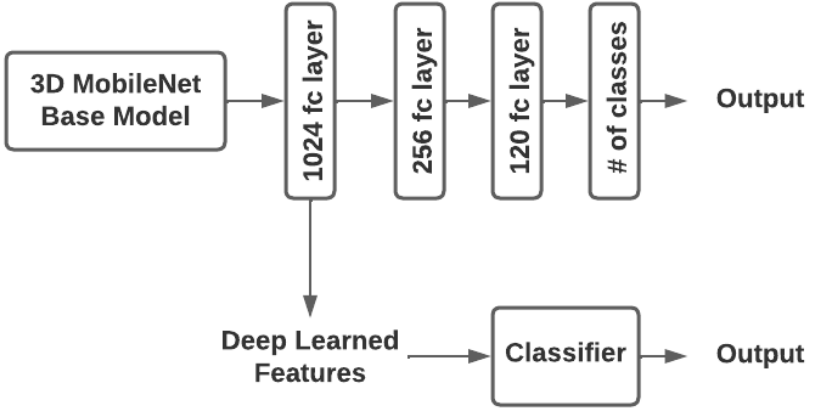
Figure 6. MobileNet Block (fc: Fully connected layer, #